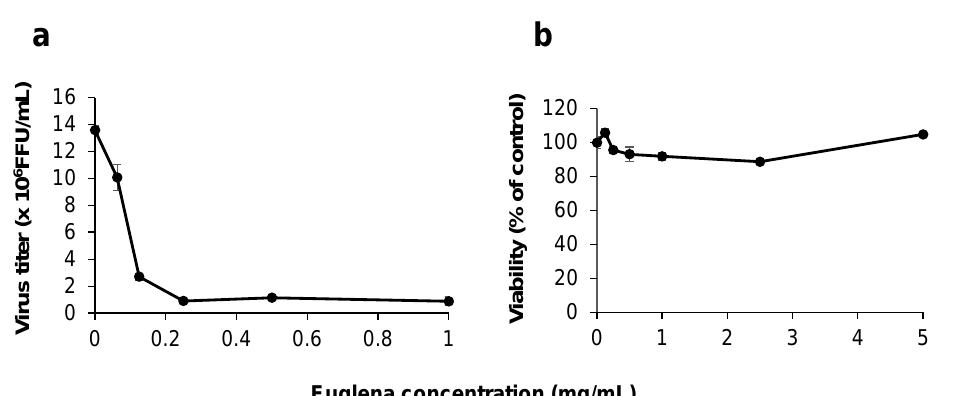
Figure 1. Anti-influenza effect of Euglena extract: ( a ) Viral titer in Madin–Darby canine kidney (MDCK) cells infected with influenza virus strain A/PR/8/34, as determined using the focus-forming reduction assay at 24 h after infection; ( b ) viability of MDCK cells infected with strain A/PR/8/34 after adding Euglena extract. The data are from three independent experiments and the error bars indicate standard deviation ( n = 3). FFU: focus forming units.